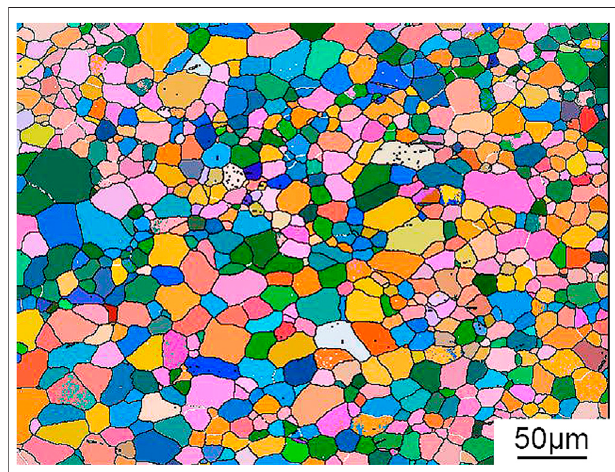
FIGURE 1 | The initial microstructure of the base